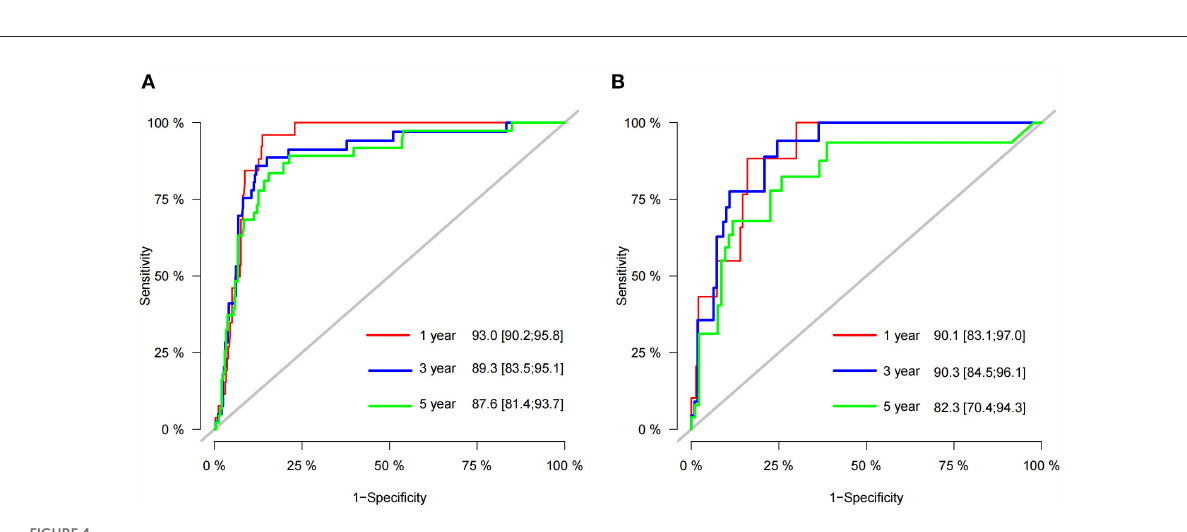
FIGURE4 AUC for predicting 1-, 3-, and 5-year CSS in the training set (A) and validation set (B)